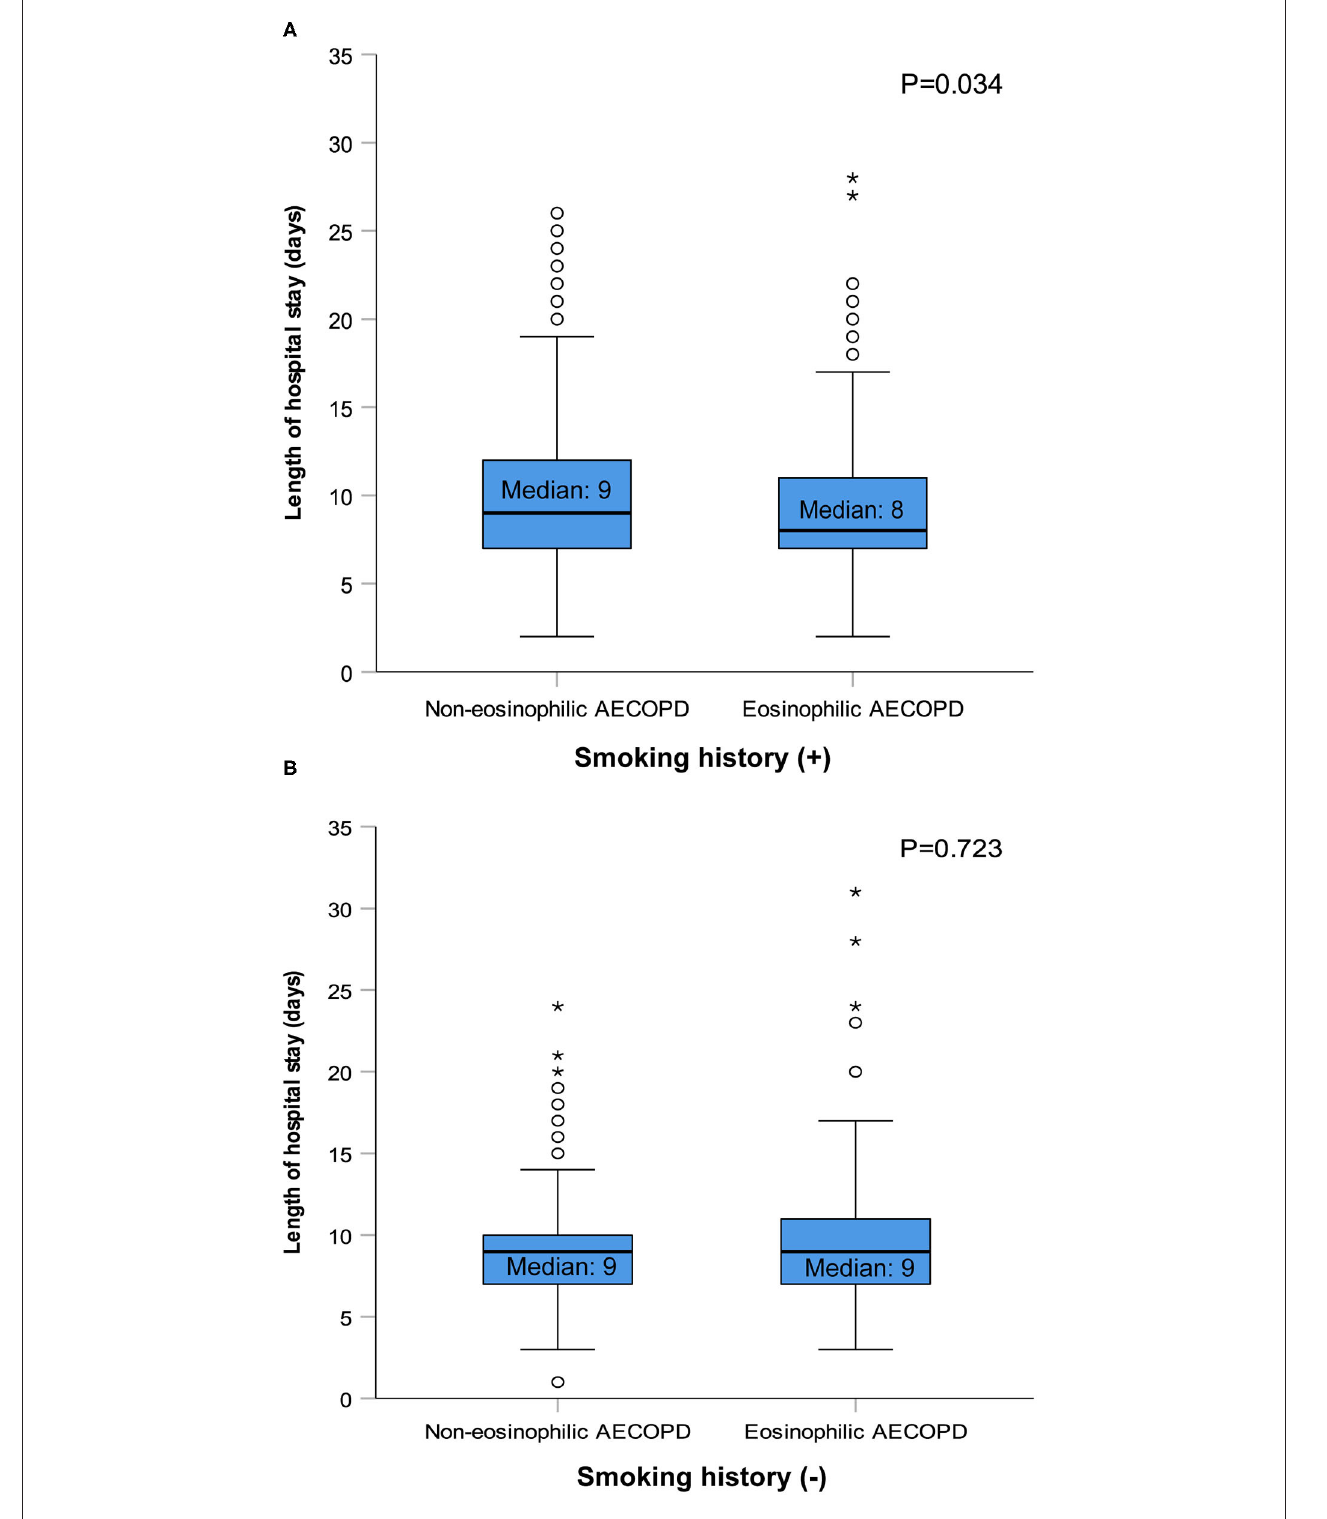
FIGURE 2 | Length of hospital stay in patients with or without smoking history after matching. AECOPD, acute exacerbations of chronic obstructive pulmonary disease. The circles and asterisks are outliers.